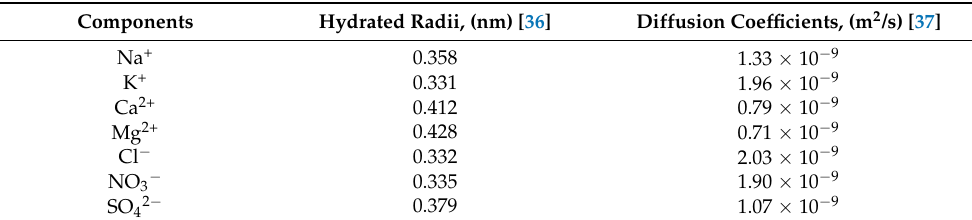
Table 1. Common components in brackish waters and their hydrated radii and diffusion coefficients in